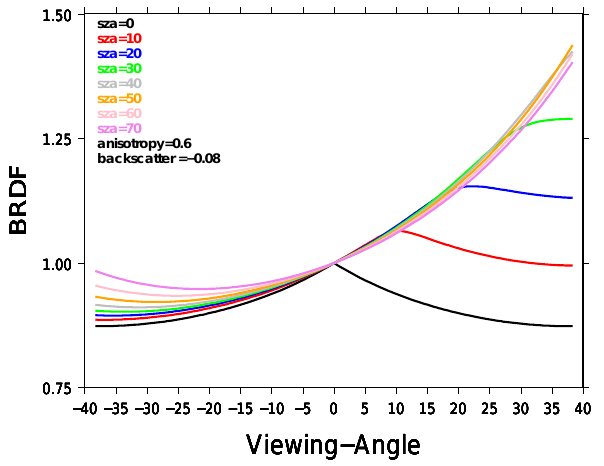
Fig. A1. B RDF as used for the retrieval of aerosol optical depth over Germany for different solar zenith angles (Sinyuk et al., 2006).